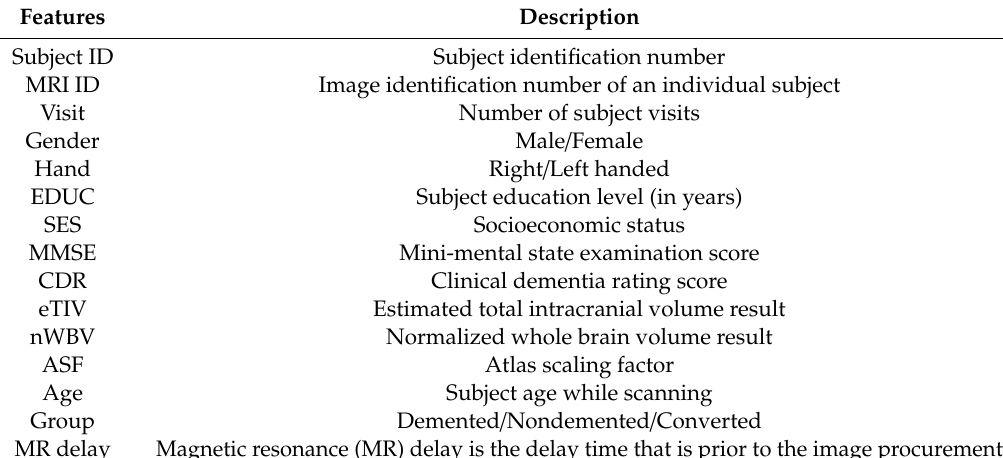
Table 4. Dataset feature description.